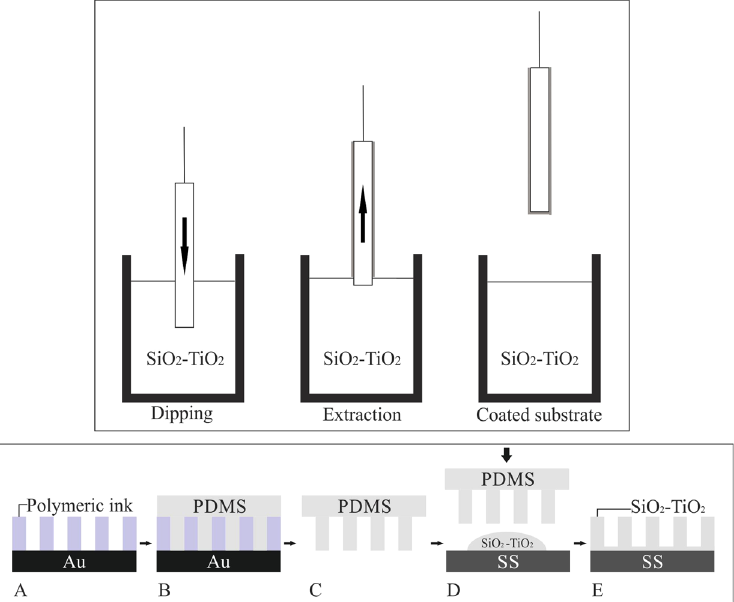
Figure 1. Top: dip coating of SS316L using SiO 2 -TiO 2 suspension. Bottom: patterning process using microstamping. Pattern fabrication on gold ( A ), PDMS pre-polymer poured onto pattern ( B ), PDMS stamp after polymerization ( C ), microstamping using SiO 2 -TiO 2 suspension ( D ) and transferred SiO 2 -TiO 2 pattern on